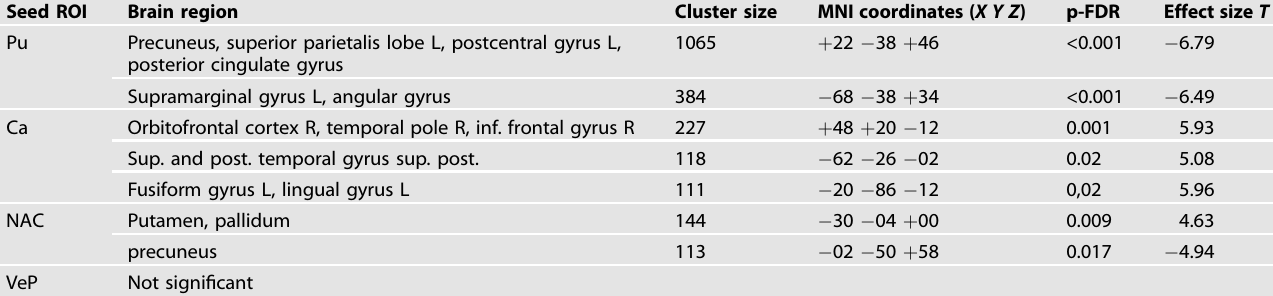
Table 2. Correlation of polygenic risk scores (PRS) with functional connectivity.